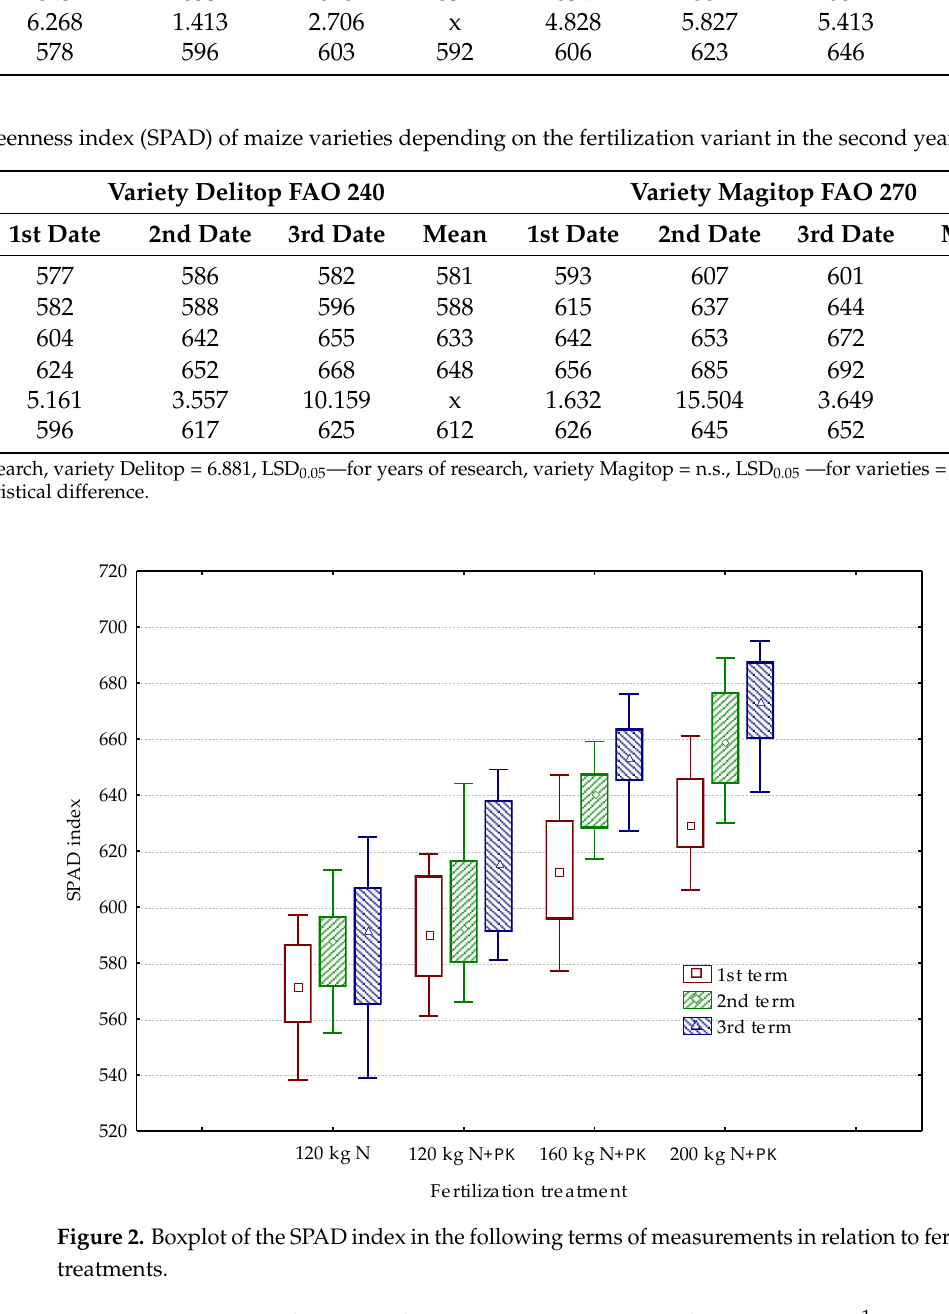
624 Table 3. The leaf greenness index (SPAD) of maize varieties depending on the fertilization variant in the second year. Fertilization Variant